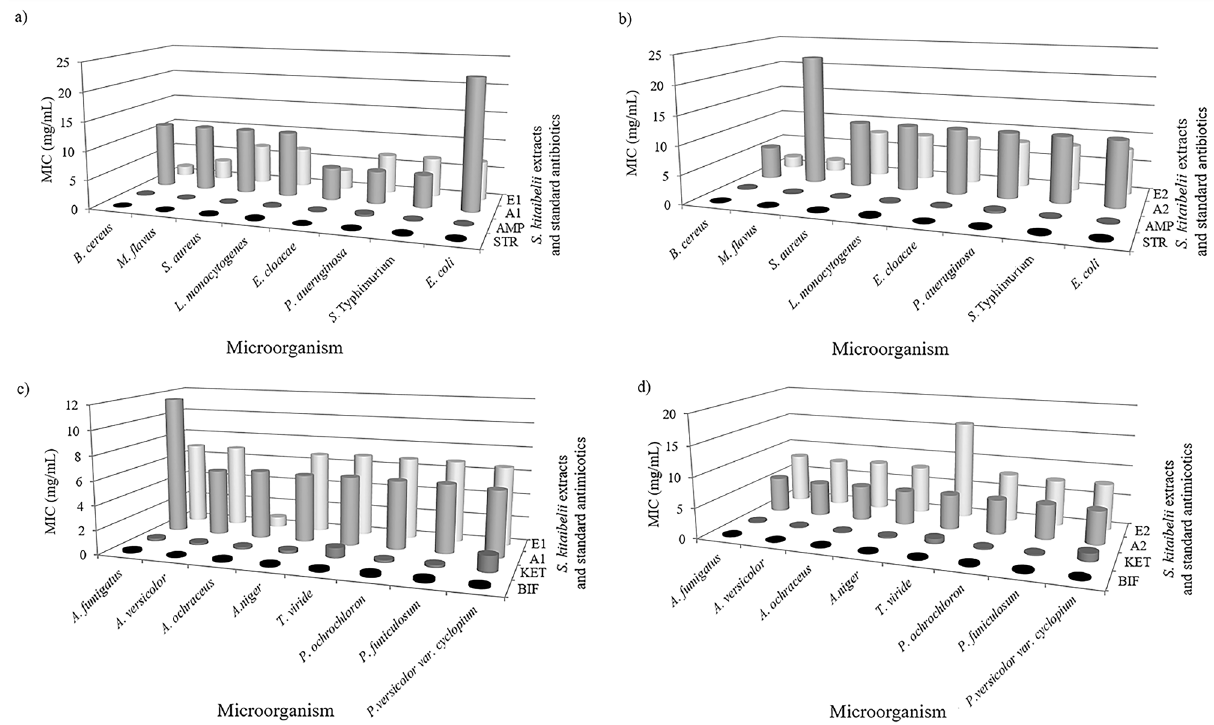
Figure 2. Antibacterial ( a , b ) and antifungal activity ( c , d ) of aqueous and ethyl acetate extracts of stems, leaves and flowers (A1 and E1, respectively) and leaves and flowers (A2 and E2, respectively) of S. kitaibelli . MIC— minimal inhibitory concentration, (mg/mL); STR—streptomycin; AMP—ampicillin; BIF—bifonazole; KET— ketoconazole. Detailed data on all microorganisms are given in the Supplementary Table